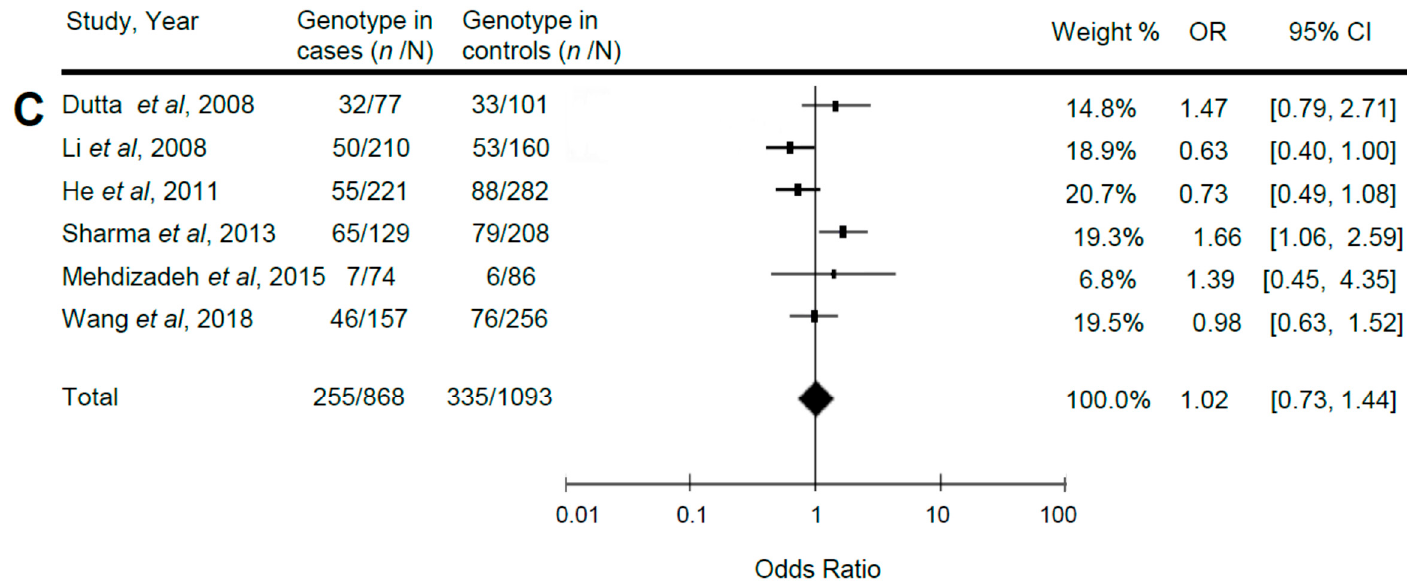
Figure 2. Meta-analysis of the association of reelin gene polymorphisms with autistic spectrum disorder (ASD). ( A) : Distribution of the genotype CC of the exon 22 polymorphism (rs362691) compared between patients with ASD (cases) and healthy controls under a random effects model. ( B ): Distribution of the genotype TT of the exon 50 polymorphism (rs2229864) compared between patients with ASD (cases) and healthy controls under a random effects model. ( C ): Distribution of the genotype TT of the intron 59 polymorphism (rs736707) compared between patients with ASD (cases) and healthy controls under a random effects model.